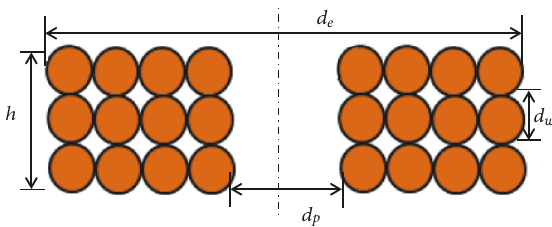
Figure 5: Cross-sectional view of wound